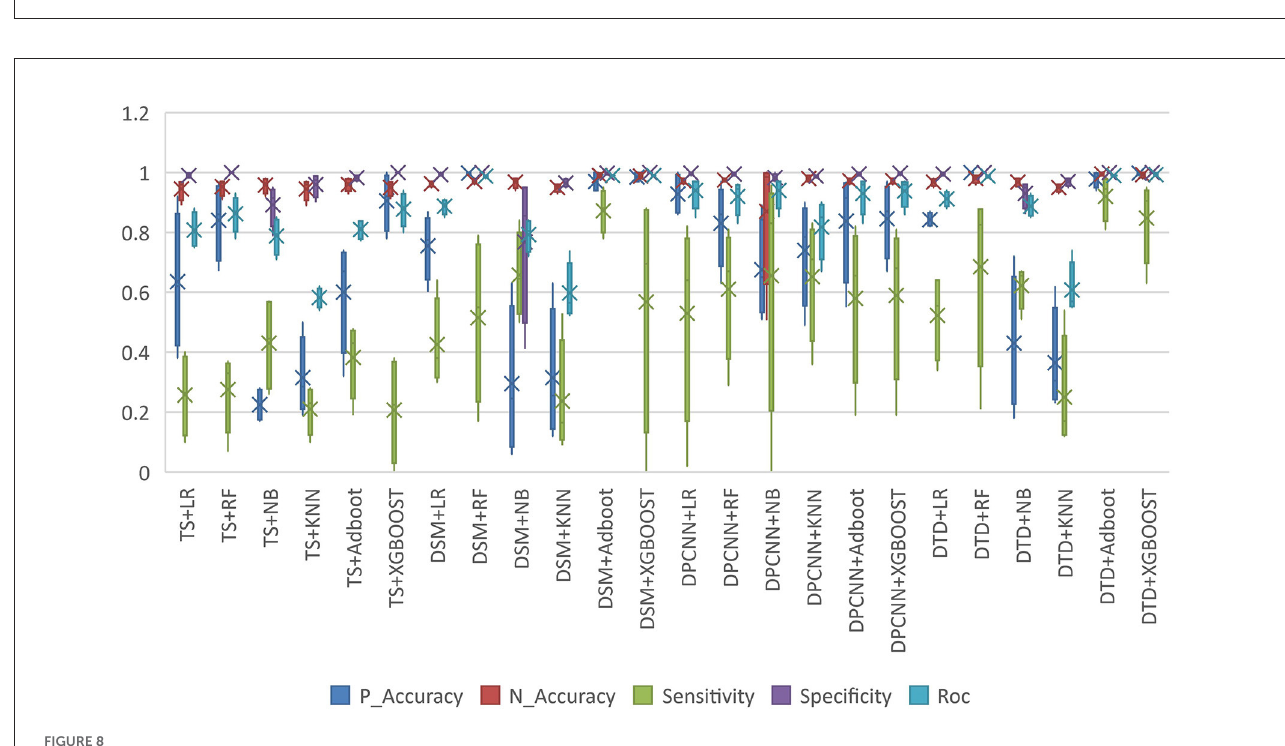
FIGURE8 Model performance